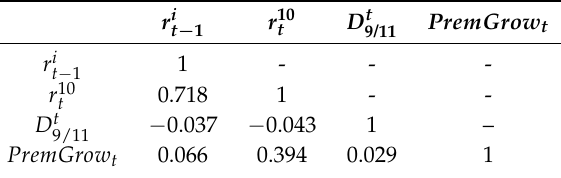
Table 2. Correlation matrix for econometric